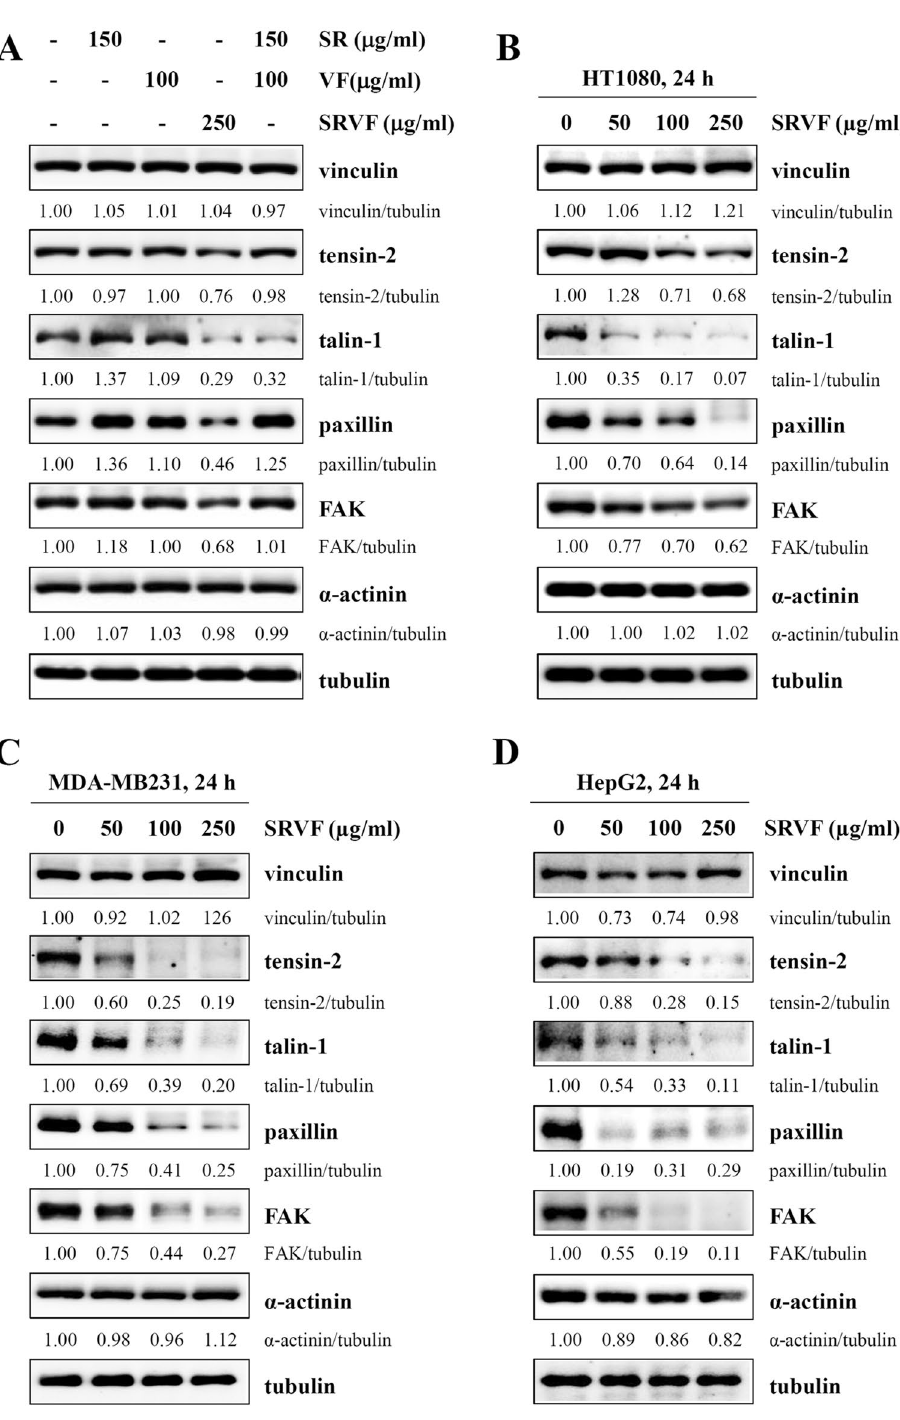
tumor growth and decreased tumor weight by approximately 30.12%, compared with saline treatment, whereas SR and SR + VF treatment did not suppress tumor growth (Supplementary Fig. 10). It is believed that normal epithelial cells must attach to the ECM to survive and, when cells lose cell-matrix adhesion, they rapidly undergo a form of apoptosis known as anoikis 3,5 . In contrast, during tumor progression,